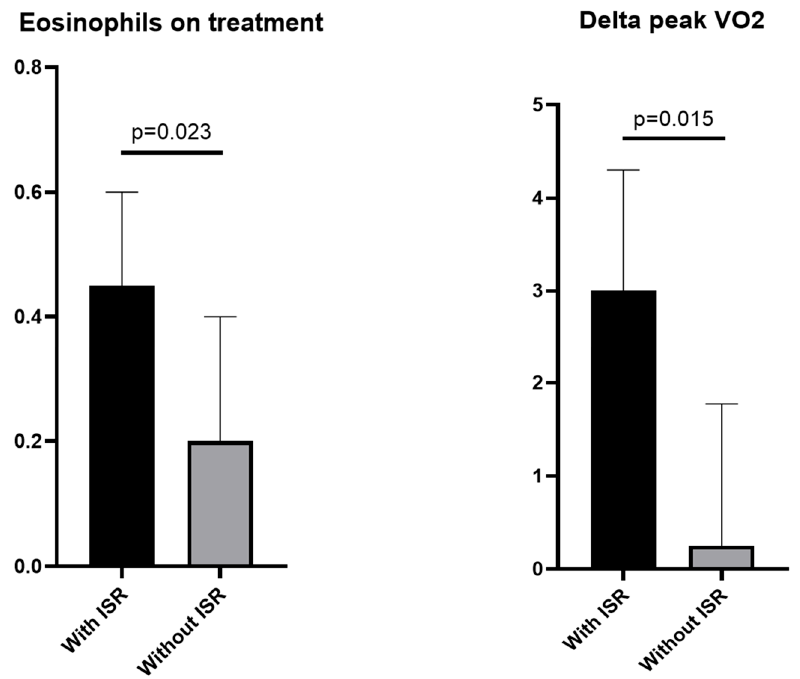
Figure 3. Injection site reactions, eosinophils, and peak VO 2 changes. We found a statistically significant difference in eosinophils ( left panel) and change (delta) in peak VO 2 ( right panel) between patients who experienced and did not experience injection site reactions. Abbreviation: ISR, injection-site reactions.